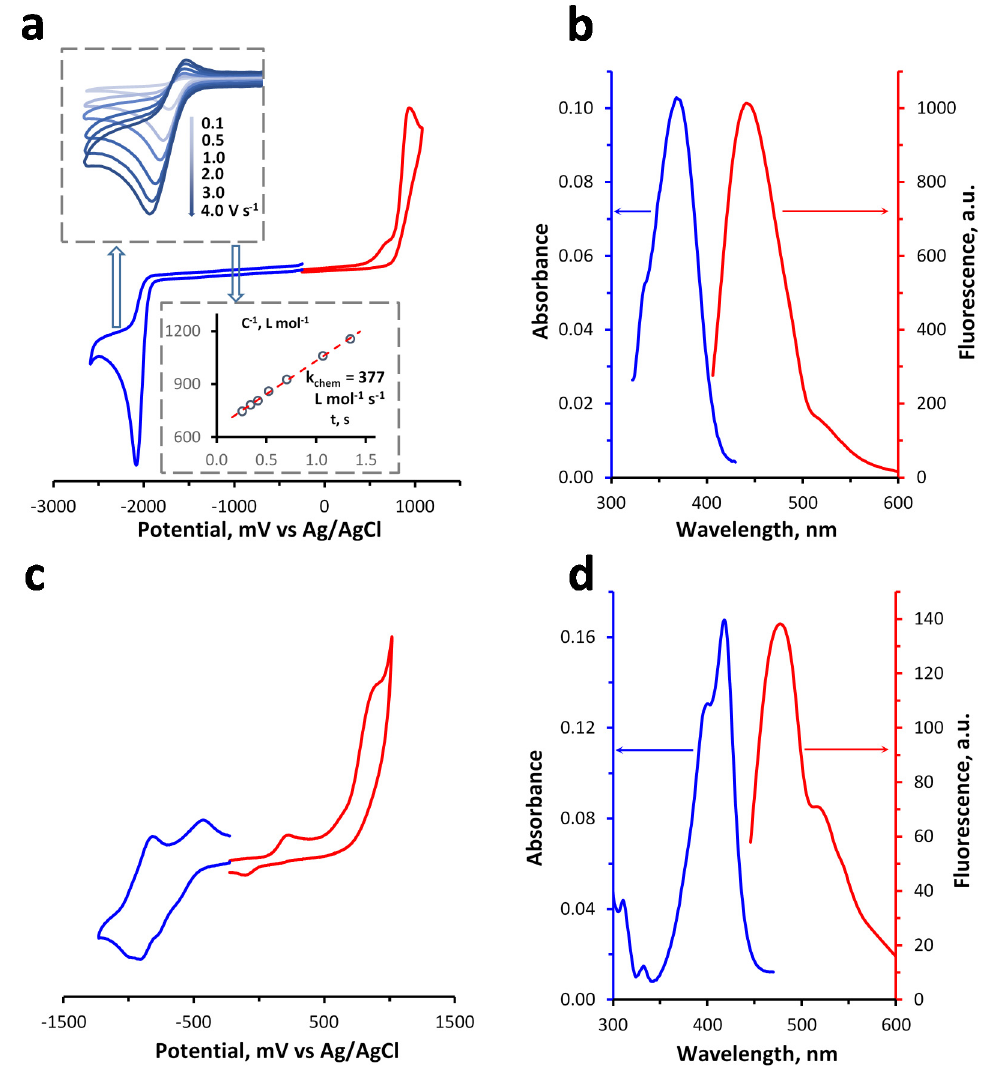
Figure 2. CV curves of the oxidation (red) and reduction (blue) of complexes 1 ( a ) and 4 ( c ) (C = 3 mM) in a 0.1 M Bu 4 NBF 4 /DMF supporting electrolyte on a glassy carbon disc electrode at a potential scan rate of 100 mV s − 1 . Insets show the reduction curves for 1 at various scan rates and second-order kinetic plot for the chemical reaction following the electrochemical reduction of 1 . Circles are experimental data points, whereas the dashed line is a linear fit. Absorption (blue) and fluorescence (red) spectra of 1 ( b ) and 4 ( d ) in DMF (C = 0.1 mM).